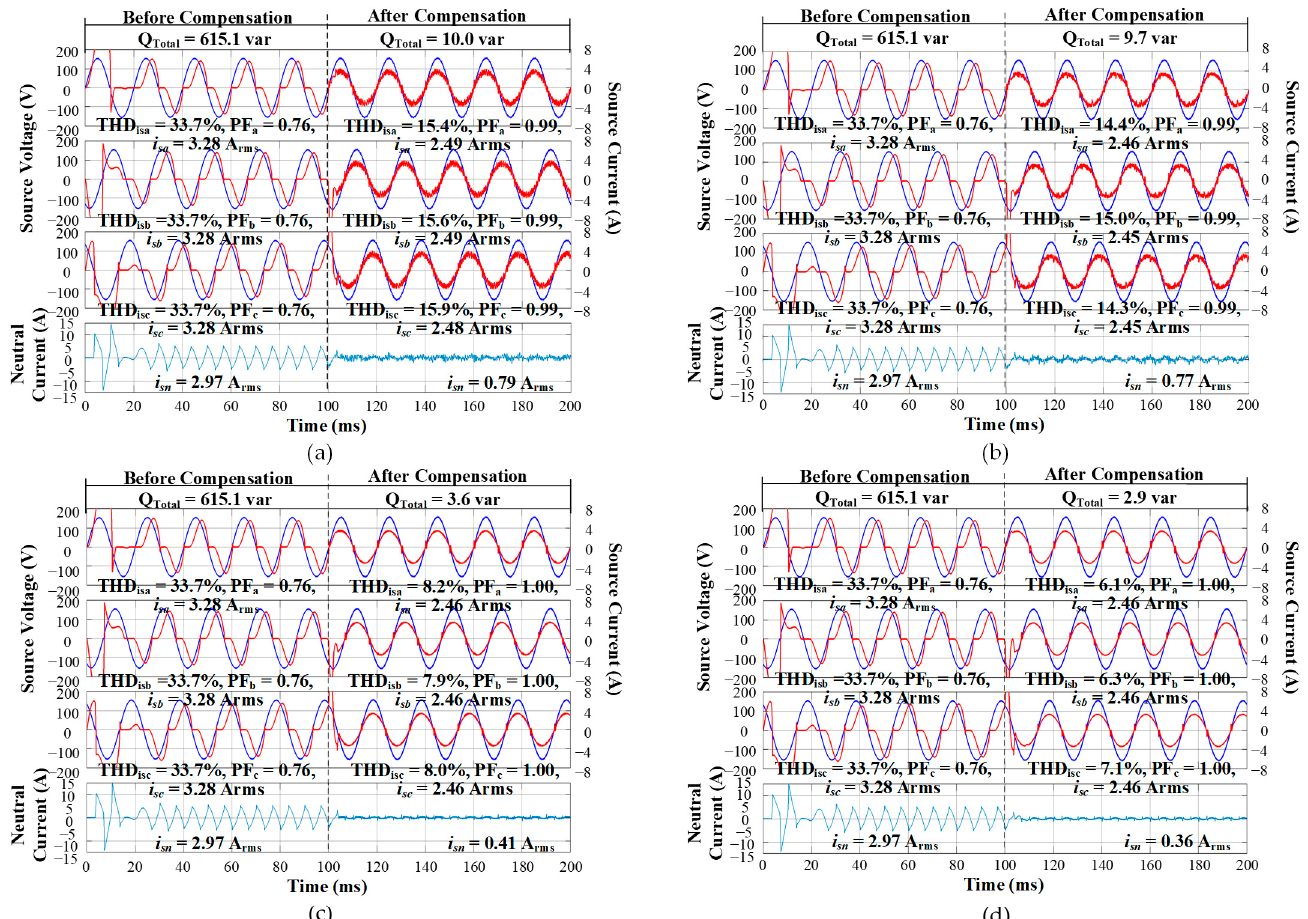
Figure 6. Simulation results of three-phase PCC voltage, source current and neutral current before and